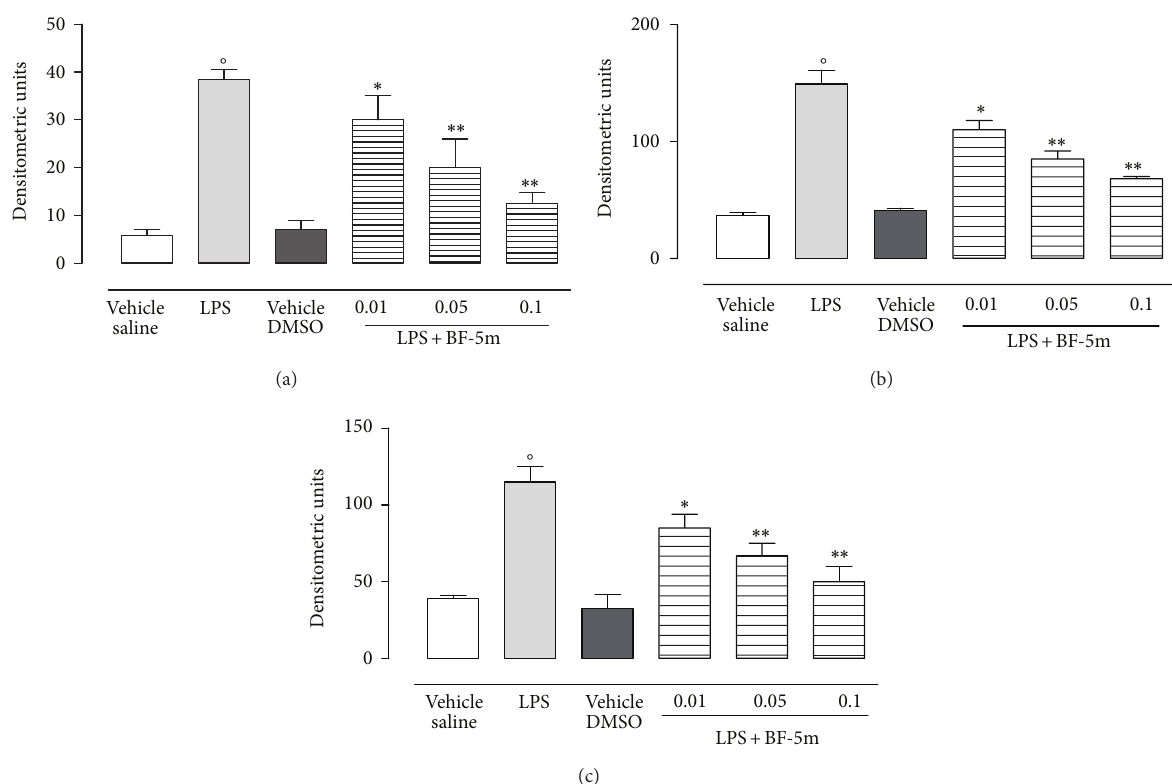
Figure 3: Western blotting analysis for ubiquitin, proteasome 20S, and proteasome 26S subunits. Injection of BF-5m (0.01; 0.05; 0.1 𝜇 M/rat) into the vitreous of LPS-treated rats dose-dependently reduced the expression of ubiquitin (a), protesome 20S (b), and proteasome 26S (c). Results are expressed as densitometric units and represented the mean ± SEM of 𝑛 = 6 observations for each group. ∗ 𝑃 < 0.05 and ∗∗ 𝑃 < 0.01 versus LPS-treated rats; ∘ 𝑃 < 0.01 versus vehicle saline